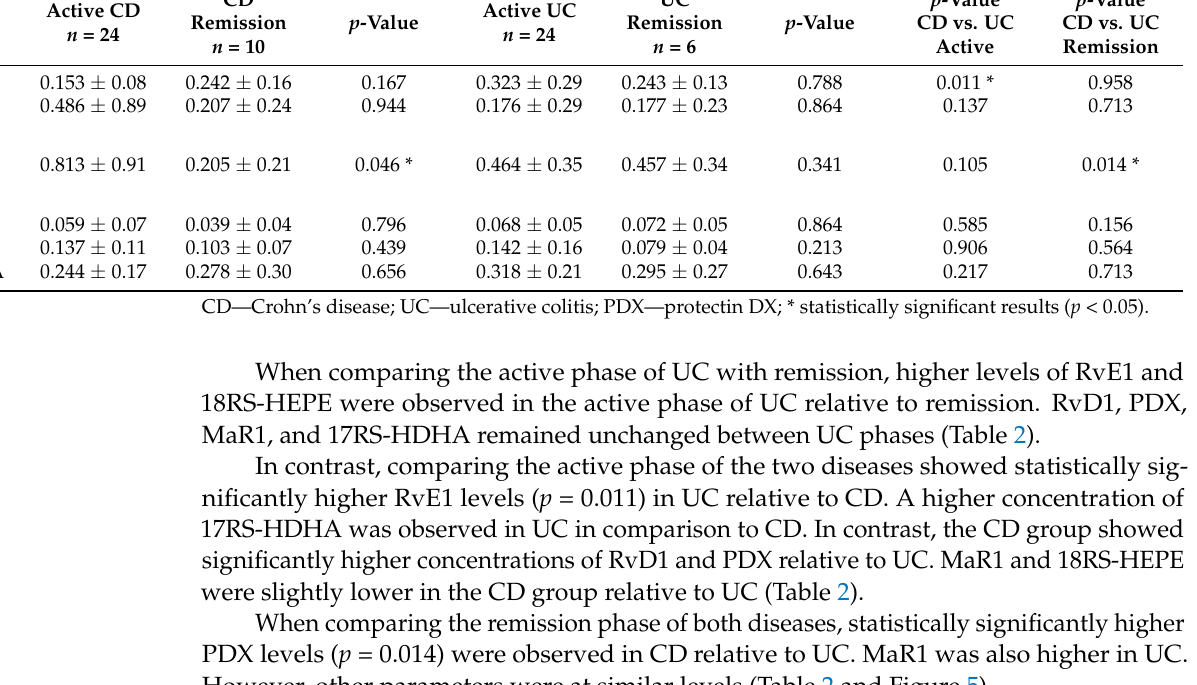
Table 2. Characteristics of lipid mediators in CD and UC groups with disease stage differentiation.